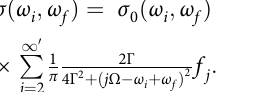
see Fig. 3f. This additional channel is also based on the interaction with the same phonon energy ~15 meV. Elastic processes could be the origin of a small offset between the experiment and the fi tted curve. To get a better understanding of the relaxation pathways, we consider different scattering mechanisms. Scattering within the same valley is not plausible, due to the mismatch of BZ centre phonon energies 61 . The energy ~15 meV could correspond to either Γ − K or Γ − Λ phonons. The phonon dispersion in 1L- WSe 2 shows acoustic phonons with energies ~15 meV 46,61 . These have a fl at dispersion, necessary to observe the high number of Fig. 3a.